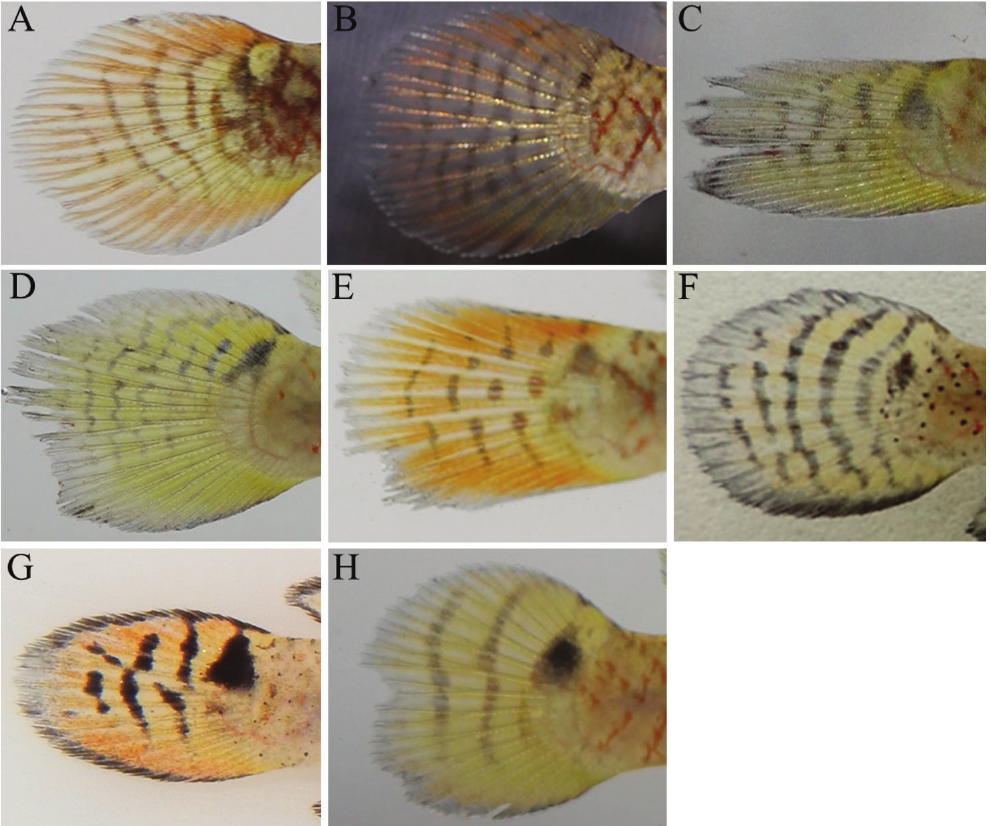
Figure 13. Variation of colour pattern of the caudal fin of females of different species of the Melanorivulus pictus specis group from Rio Paraná, Brazil. A) M. amambaiensis ; B) M. apiamici ; C) M. egens; D) M. interruptus ; E) M. ivinhemensis ; F) M. nigropunctatus ; G) M. ofaie ; H) M. scalaris